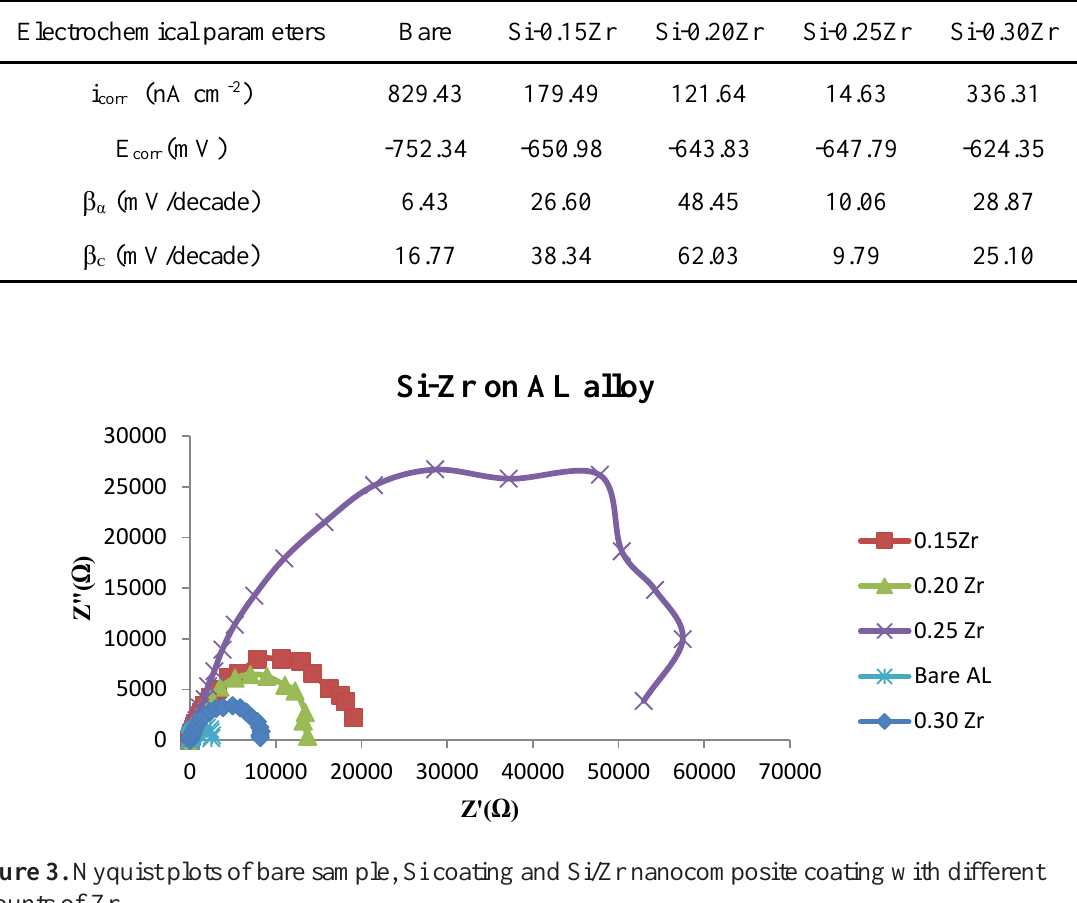
Figure 2. Potentiodynamic polarization curves of bare, coating and nanocomposite coating with 0.15, 0.20, 0.25, 0.3 Zr. Table 1. Electrochemical parameters of uncoated and Silica-Zirconia nanocomposite coatings